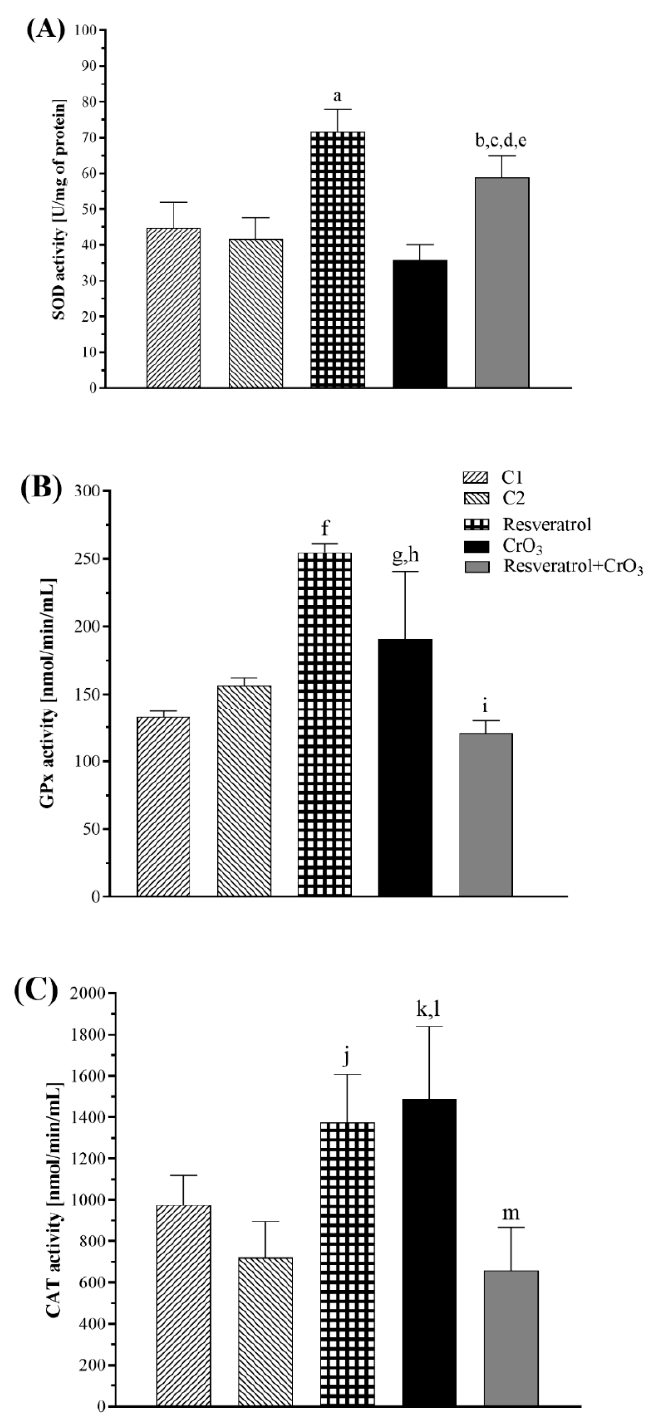
Figure 3. ( A ) Superoxide dismutase (SOD), ( B ) glutathione peroxidase (GPx), and ( C ) catalase (CAT) activities evaluated in peripheral blood at 48 h after treatments with resveratrol and CrO 3 ( n = 5